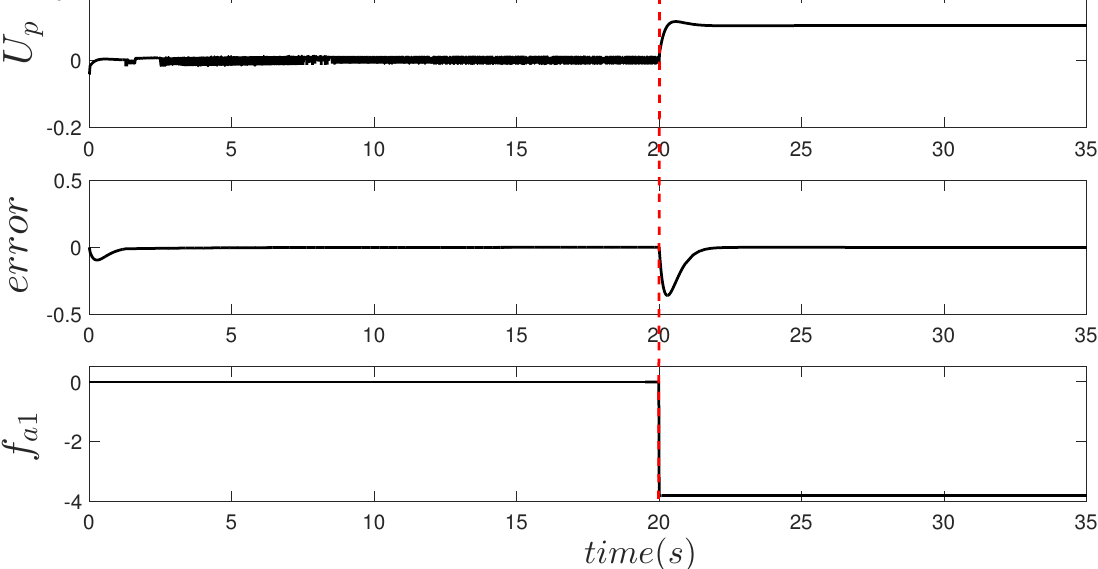
Figure 6. Behavior of the control signal, regulation error and fault in both states, where the fault is present in the actuator one, that is, f a 1